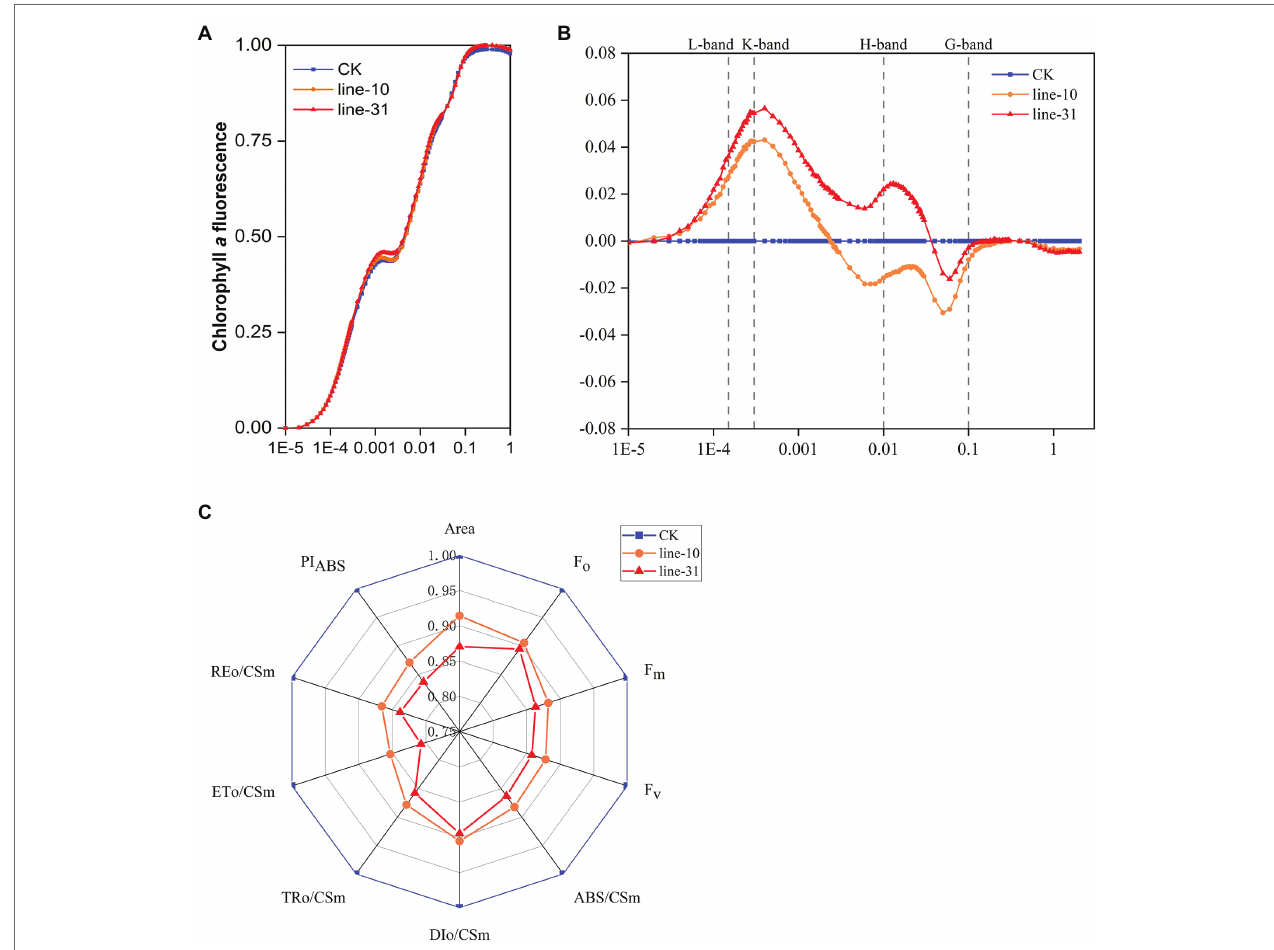
FIGURE 8 | Chlorophyll fluorescence induction curves analysis of ZjNOL -overexpressing transgenic lines. (A) The standard OJIP curves. (B) The relative variable fluorescence V t of the transient chlorophyll a fluorescence. (C) Radar plot of the fluorescence parameters. The fluorescence parameters were displayed as means of 10 replicates. The K-band and G-band between the transgenic lines and control were significantly different at p ≤ 0.05 based on Student t